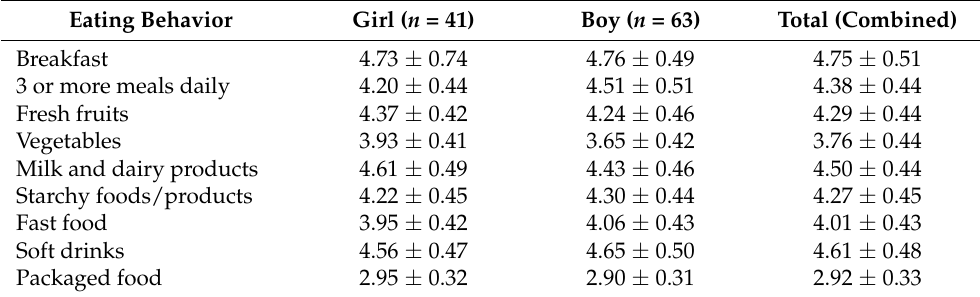
Table 2. Children Eating Behavior